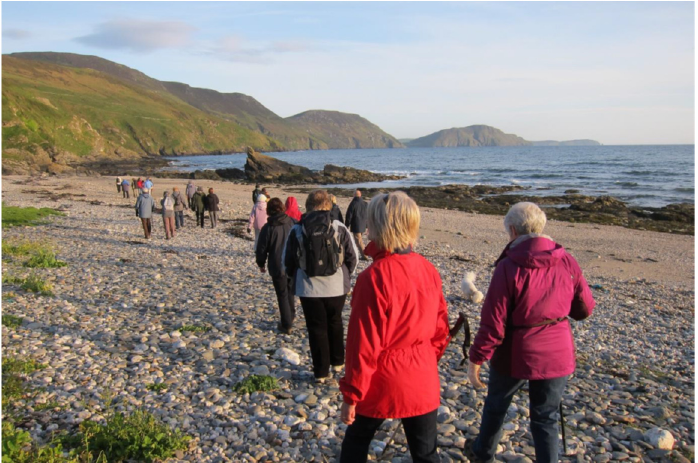
Figure 1. Praying the Keeills evening walk from Niarbyl to White Beach, West coast, Isle of Man (Source: author’s